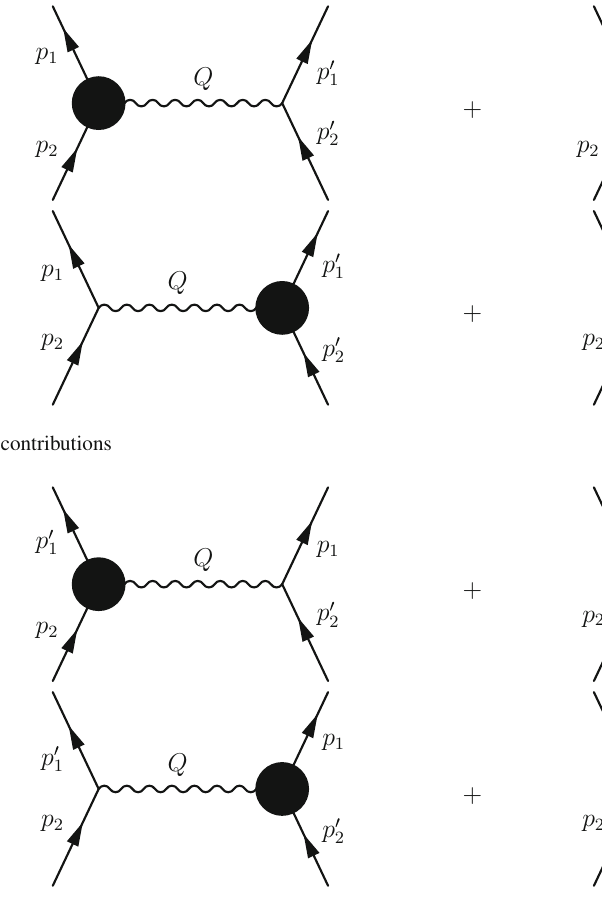
Fig. 12 Crossing S matrix